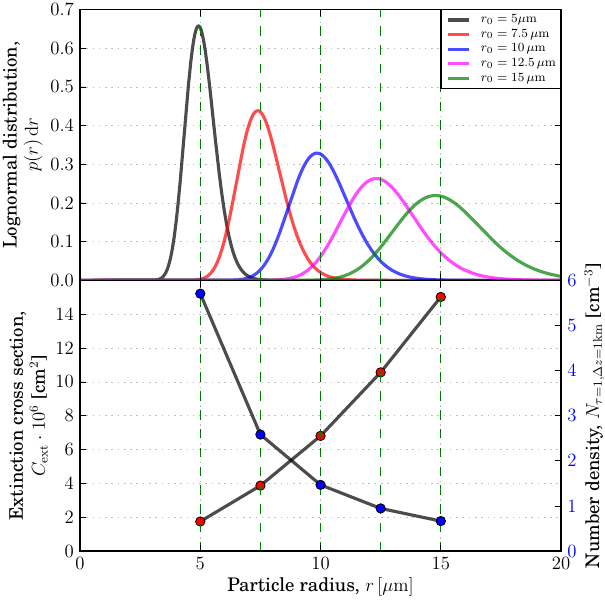
Figure 3. Top panel: lognormal droplet size distributions for me- dian radii r 0 = 5 , 7 . 5 , 10 , 12 . 5 and 15 µ m, respectively, each with a width σ 0 = 1 . 13. Bottom panel: extinction cross section C ext (cm 2 ) (red) of each size distribution (left) and the corresponding number density N (dropletscm − 3 ) (blue) for a constant cloud optical thick- ness τ = 1 and a geometric thickness (cid:49)z = 1km.